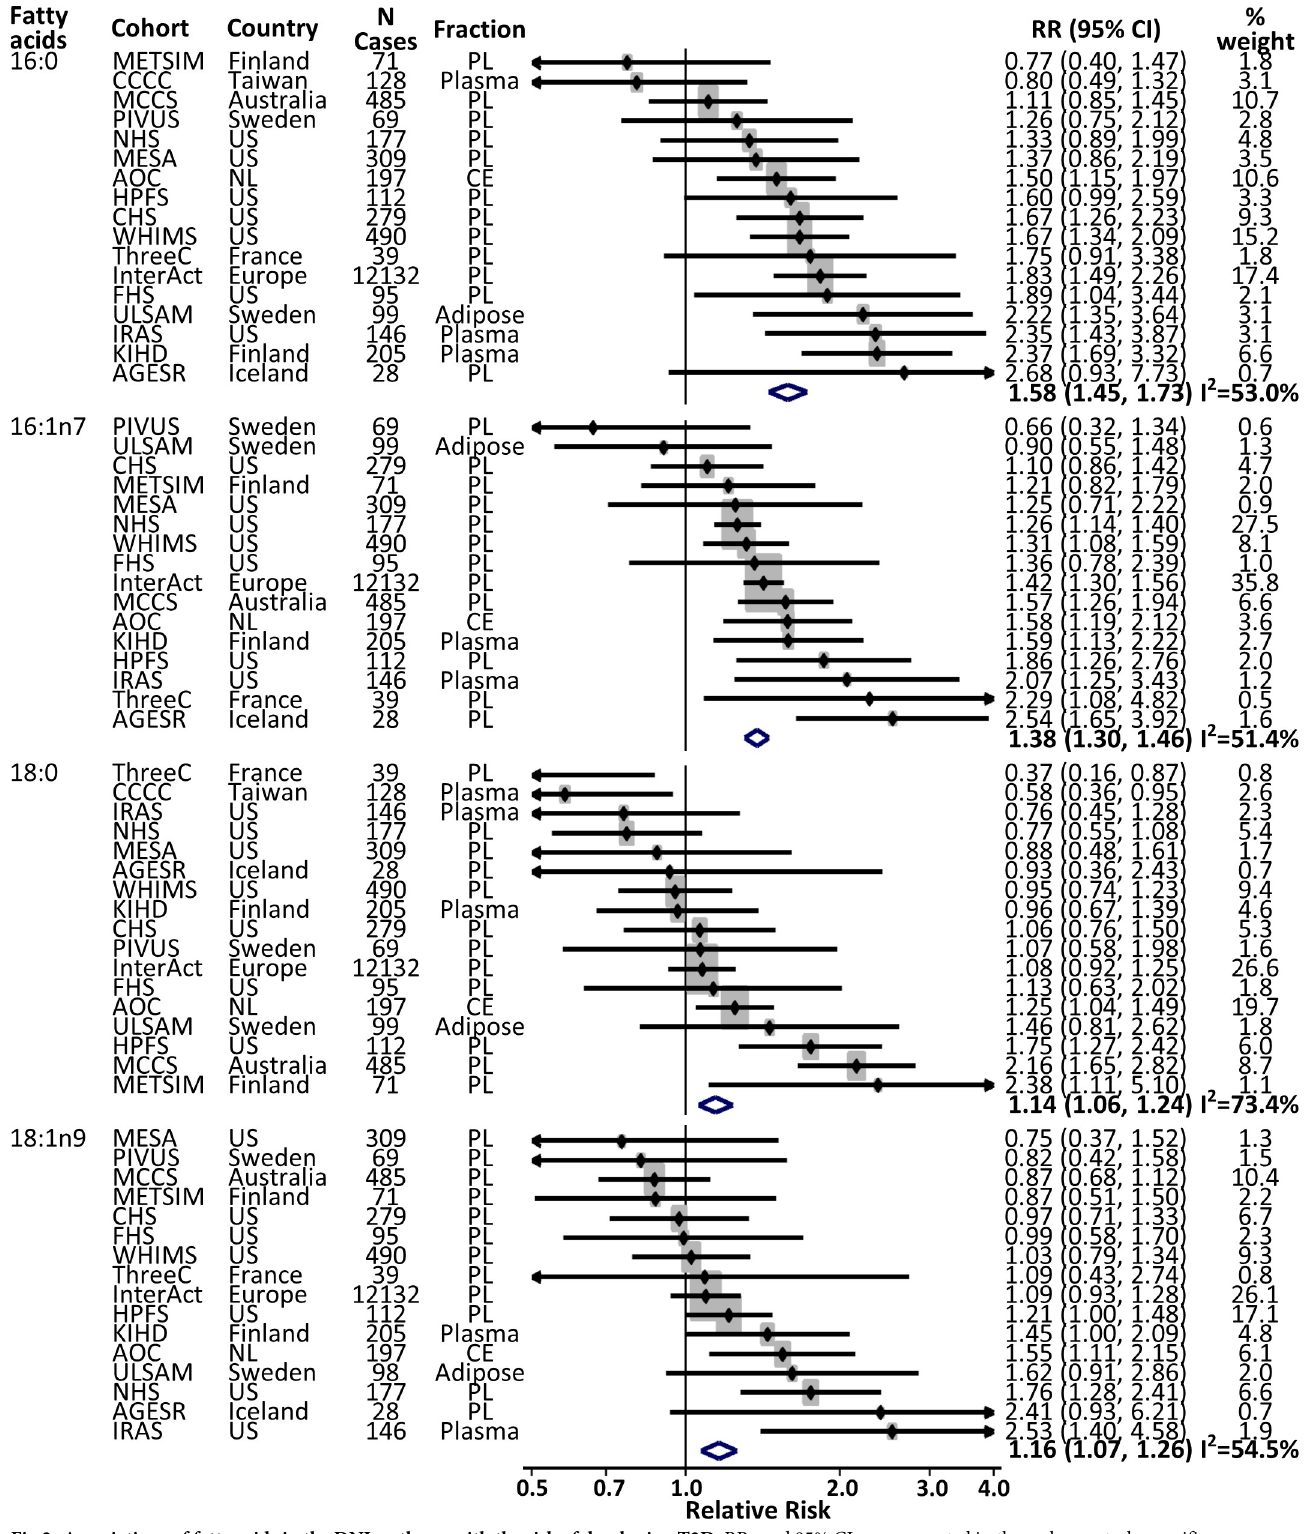
Fig 2. Associations of fatty acids in the DNL pathway with the risk of developing T2D. RRs and 95% CIs are presented in the scale per study-specific range from the midpoints of the first and fifth quintile groups (i.e., 10th to 90th percentiles): dots from individual studies and diamonds as summary estimates meta-